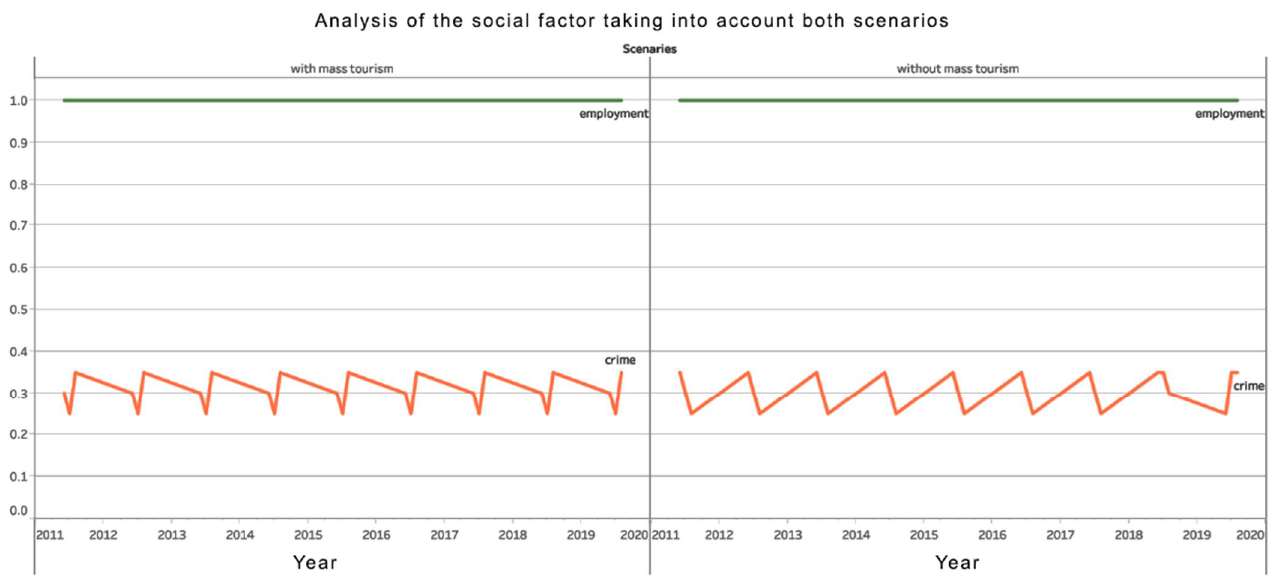
Figure 8. Analysis of economic factor indicators for the mass tourism scenario.